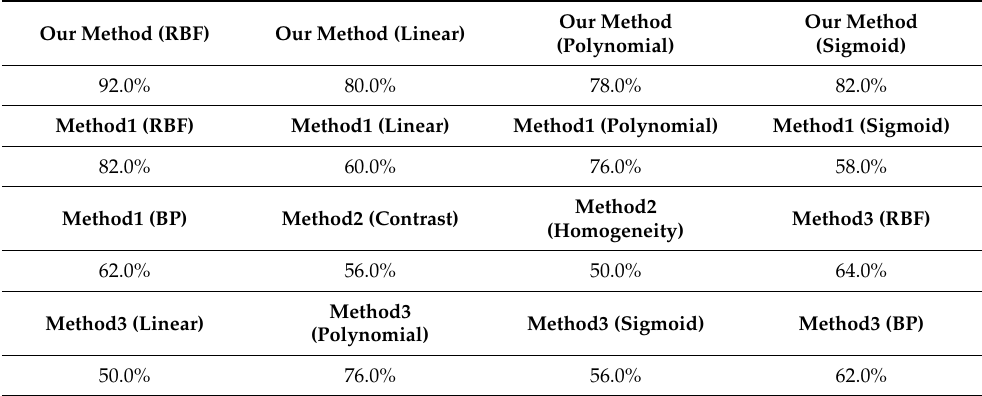
Table 18. The accuracy of different surface roughness estimation